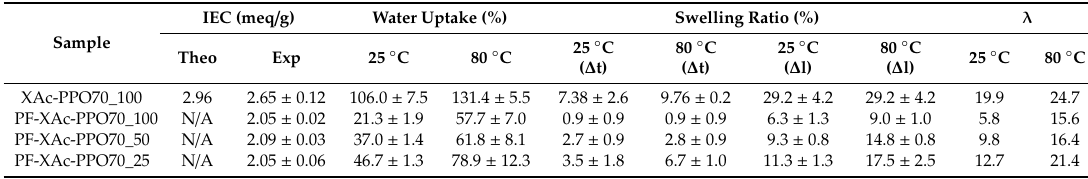
Table 2. The properties of crosslinked pore-filling